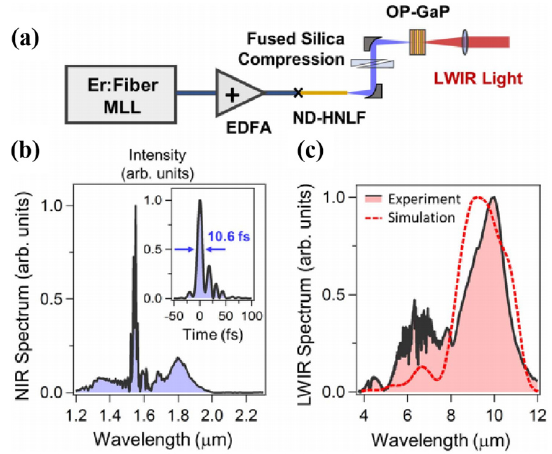
Figure 25. ( a ) Experimental layout for IPDFG comb generation. ( b ) The spectrum of this few-cycle driver. The inset of ( b ) displays the measured intensity profile of the pump pulse, corresponding to a pulse duration of 10.6 fs. ( c ) Super-octave longwave infrared (LWIR) spectra containing up to 0.25 mW of power. Reprinted with permission from [24].